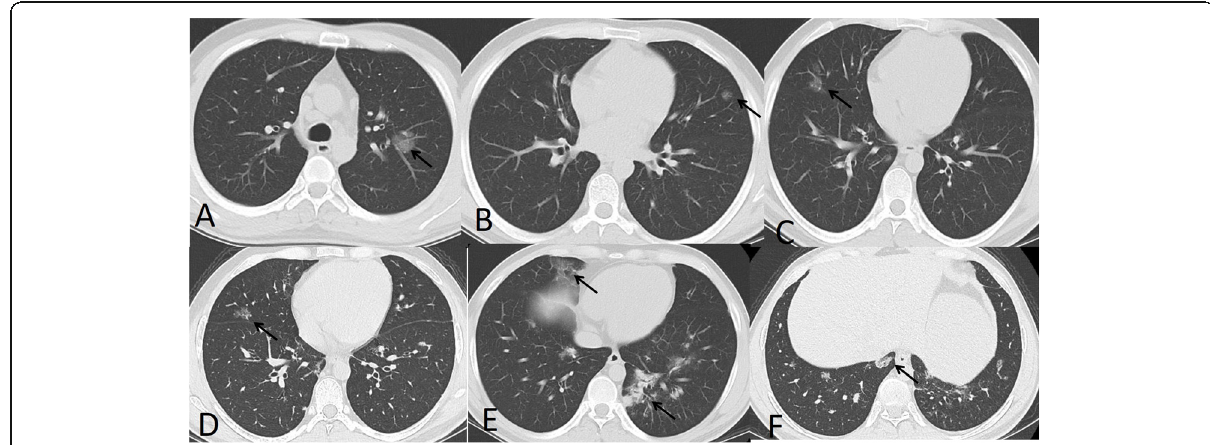
Fig. 4 A 34-year-old male presented with multiple rounded ground glass opacities (black arrows in a – d and f ) and consolidation patches with air bronchogram (black arrows in e ). Total severity score =